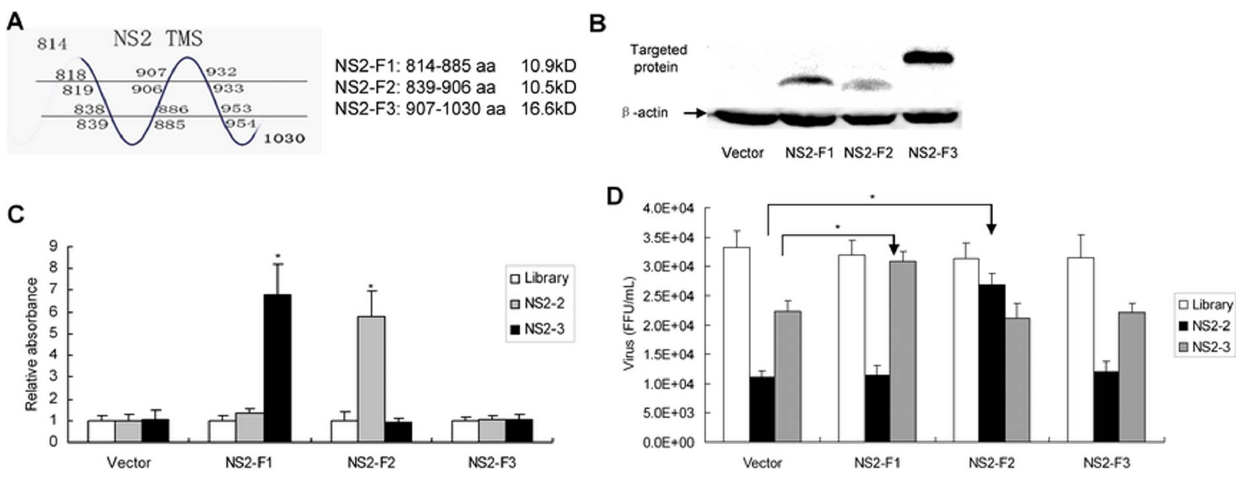
Figure 5. N-terminal region of NS2 protein is involved in the antiviral effects of NS2-specific aptamer. ( A ) Schematic of NS2. ( B ) Confirmation of the expression of different truncated versions of NS2 protein. Different truncated versions of NS2 gene were amplified and cloned into pcDNA3.1/V5-His. Huh7.5 cells were transfected by these plasmids. Different truncated versions of NS2 protein were confirmed using anti-His antibody by western blot. ( C ) Binding affinity of different truncated versions of NS2 to the aptamer. The cells were treated as described in part B. The protein was isolated from the cells and binding affinity of truncated versions of NS2 to aptamer was determined by ELONA assay. The empty vector pcDNA3.1/V5-His was used as a control vector. The data represented means of three independent experiments performed in triplicate. * P , 0.05 verse library. ( D ) Titration of HCV particles produced in HCV-infected cells transfected by truncated versions of NS2 with aptamer treatment. HCV-infected Huh7.5 cells were transfected by different truncated versions of NS2. Then the cells were treated by aptamer NS2-2 or library for 72 hours. The cell culture supernatants were harvested and titered by FFU assay on naı¨ve Huh7.5 cells. The infectivity titers are the average of three independent experiments. * P , 0.05 verse vector-transfected